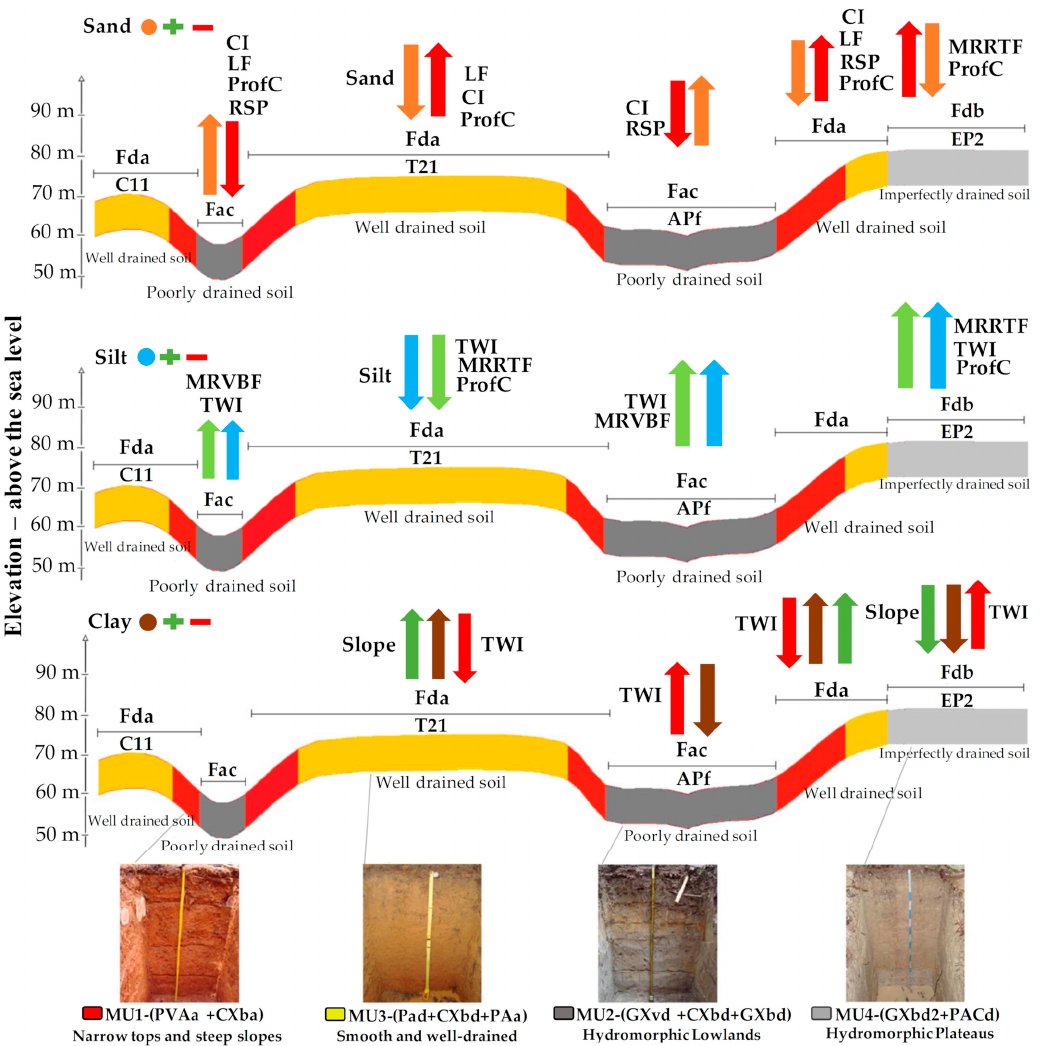
Figure 6. Soil–relief–vegetation relationships for soil sand, silt, and clay contents in the study area. Green arrow—positive correlation with the covariate; red arrow—negative correlation with the covariate. MU—mapping unit; Fac—Flooded Plain Open Tropical Forest; FDA—Dense Highland Tropical Forest; Fdb—Planalto Open Tropical Forest; APf—River plains; C11—Well-drained flat top areas; T21—Tabular Interfluves; EP2—Biplain-plain surfaces; H.S.—Holocene Sediments; P.S.—Pleistocene Sediments. (Source: modified from ref. [7]).